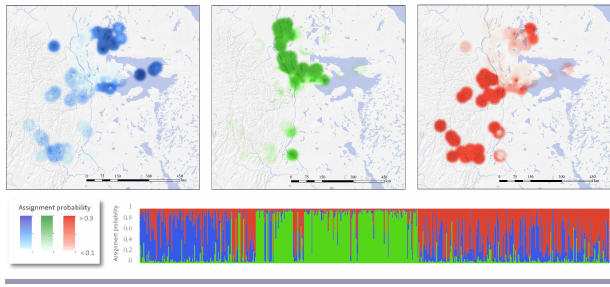
Fig. 3 . We analyzed microsatellite data from caribou ( Rangifer tarandus ) genetic samples collected in the Sahtú region and Nahanni National Park Reserve of the Northwest Territories, Canada from 2012 to 2014. We used structure software to assign individual caribou to inferred genetic clusters. We found support for K = 3 populations (shown in bottom bar) that coincided with clusters of (1) barren-ground (blue), (2) boreal woodland (green), and (3) mountain (red). Vertical colored bars indicate the probability that an individual belongs to a certain group. We mapped the structure output using the inverse- distance-weighted interpolation in ArcGIS and constrained the interpolation to the sampled